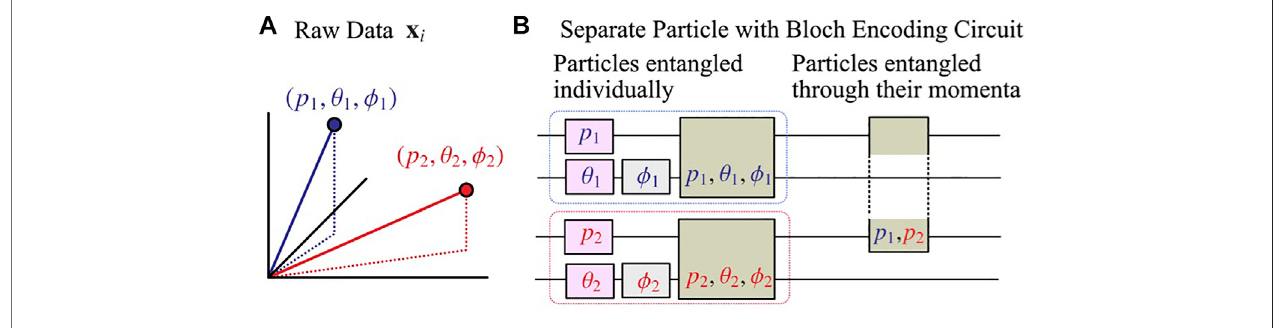
FIGURE 3 | (A) The raw data x i containing two particles with their momenta denoted by ( p i , θ i , ϕ i ) in spherical coordinates ( i = 1, 2). (B) A proposed data encoding composed of individual particle encoding with 2 qubits (each surrounded by a dashed box) and entangling between particles through their momentum bits. From